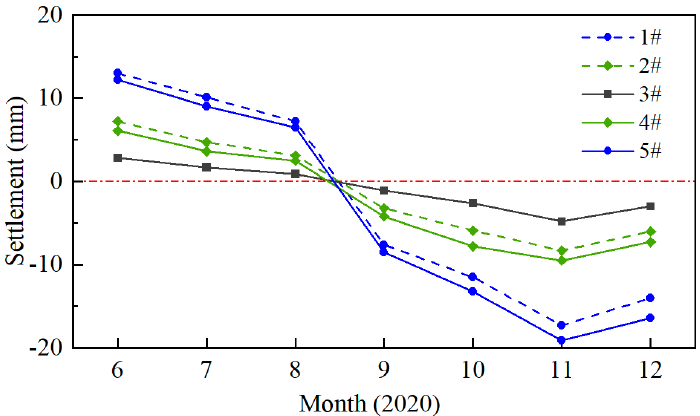
Figure 9. Position variation of subgrade surface settlement observation points relative to datum point in 2020.